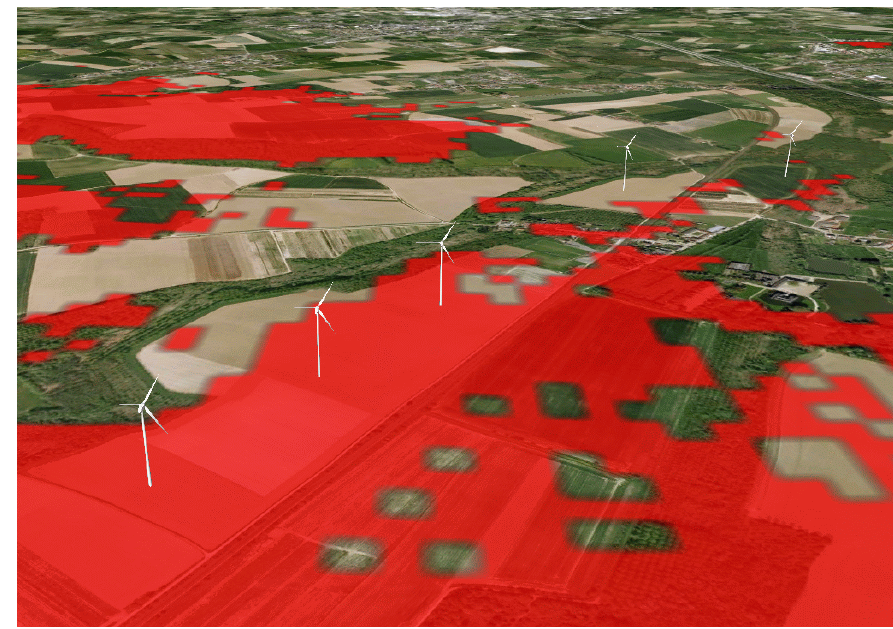
Figure 2. Results of the impact analysis on a radar. Areas in red are composed by the sets of locations where a wind turbine would degrade the radar operation